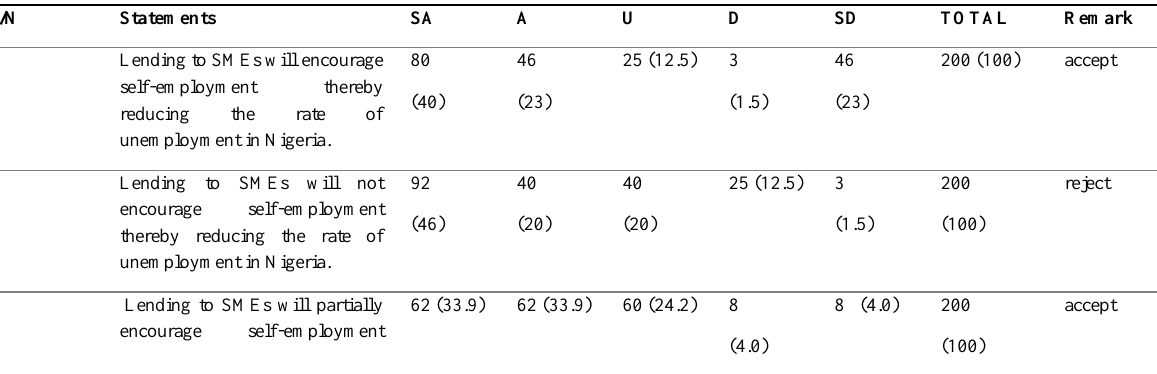
Table 2: Response on Lending to